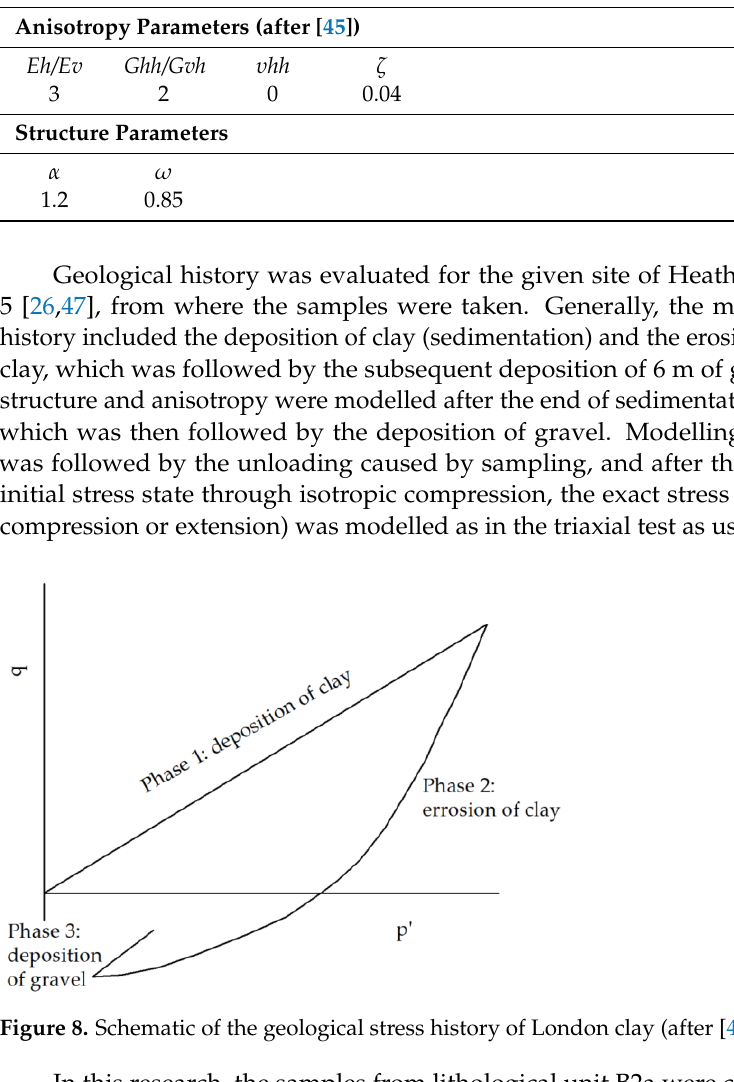
Table 3. Input parameters for SA_BRICK.